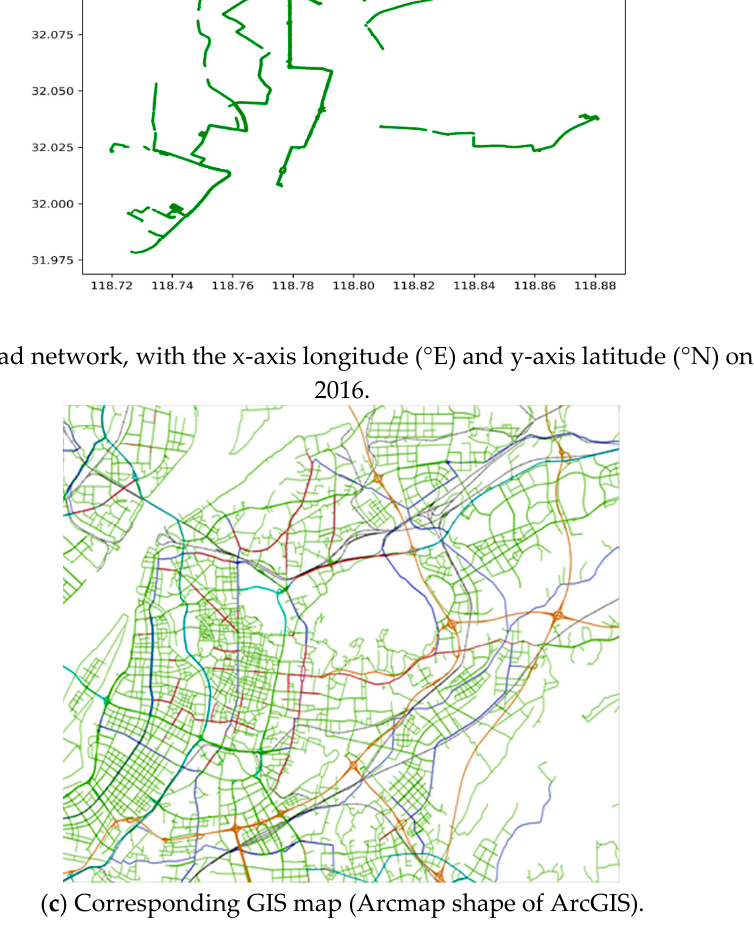
Figure 3. Bus road network and GIS map in the urban area of Nanjing city in China, according to the scatter plot of all DGNSS tracking points on 1 January 2016.